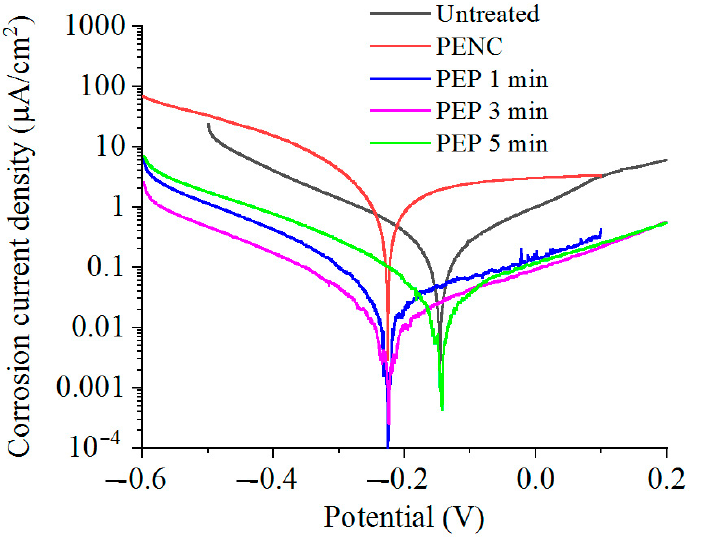
Figure 9. Potentiodynamic polarization curves of the CP-Ti samples before and after anodic PENC at 900 °C and subsequent PEP in a solution of ammonium fluoride (4%) at 300 V for different time.